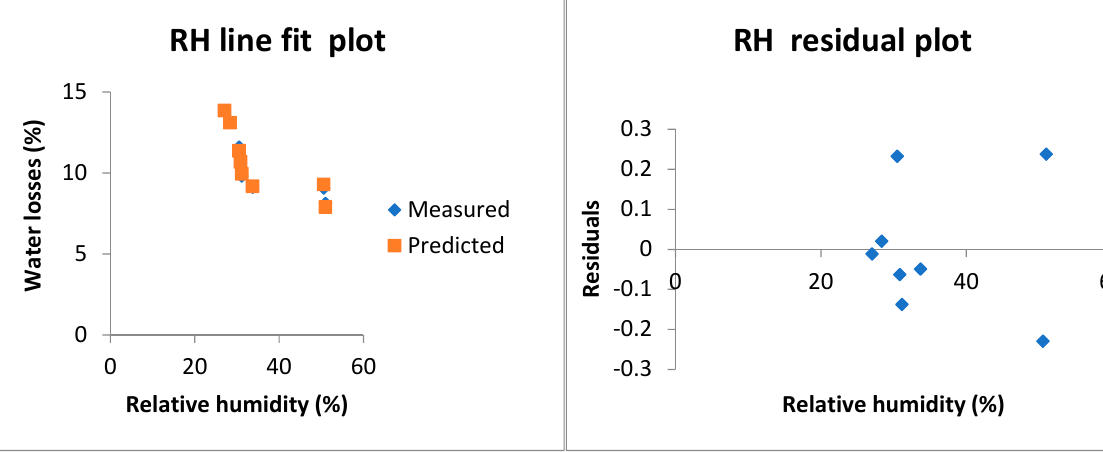
Figure 12. Measured and predicted water losses of the MLR model using the relative humidity (RH) dataset.